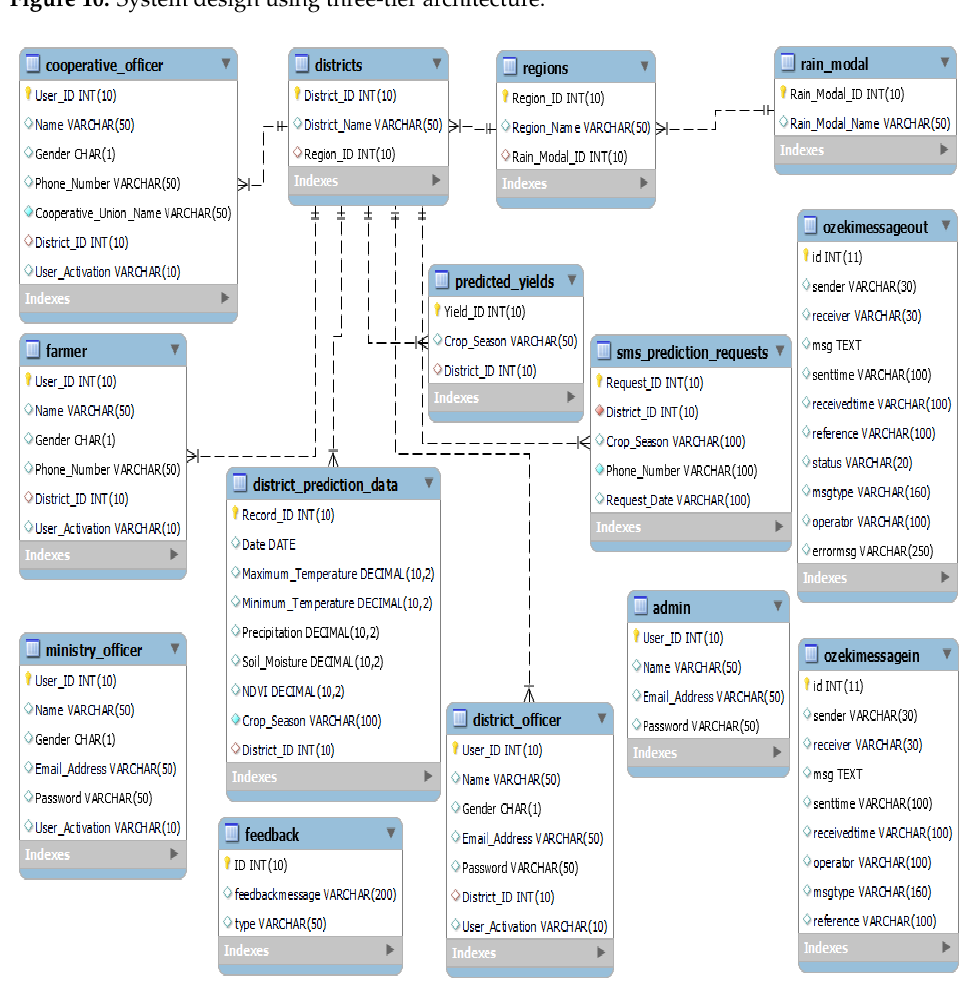
Figure 11. Entity relationship diagram with database